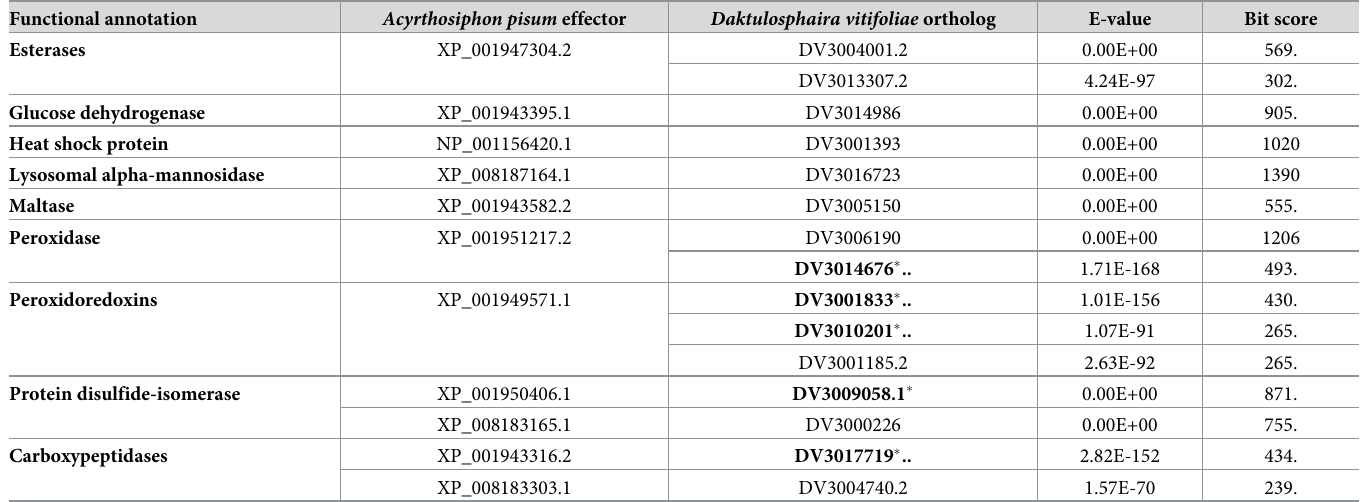
Table 3. DvEffector matches with effectors of Acyrthosiphon pisum .